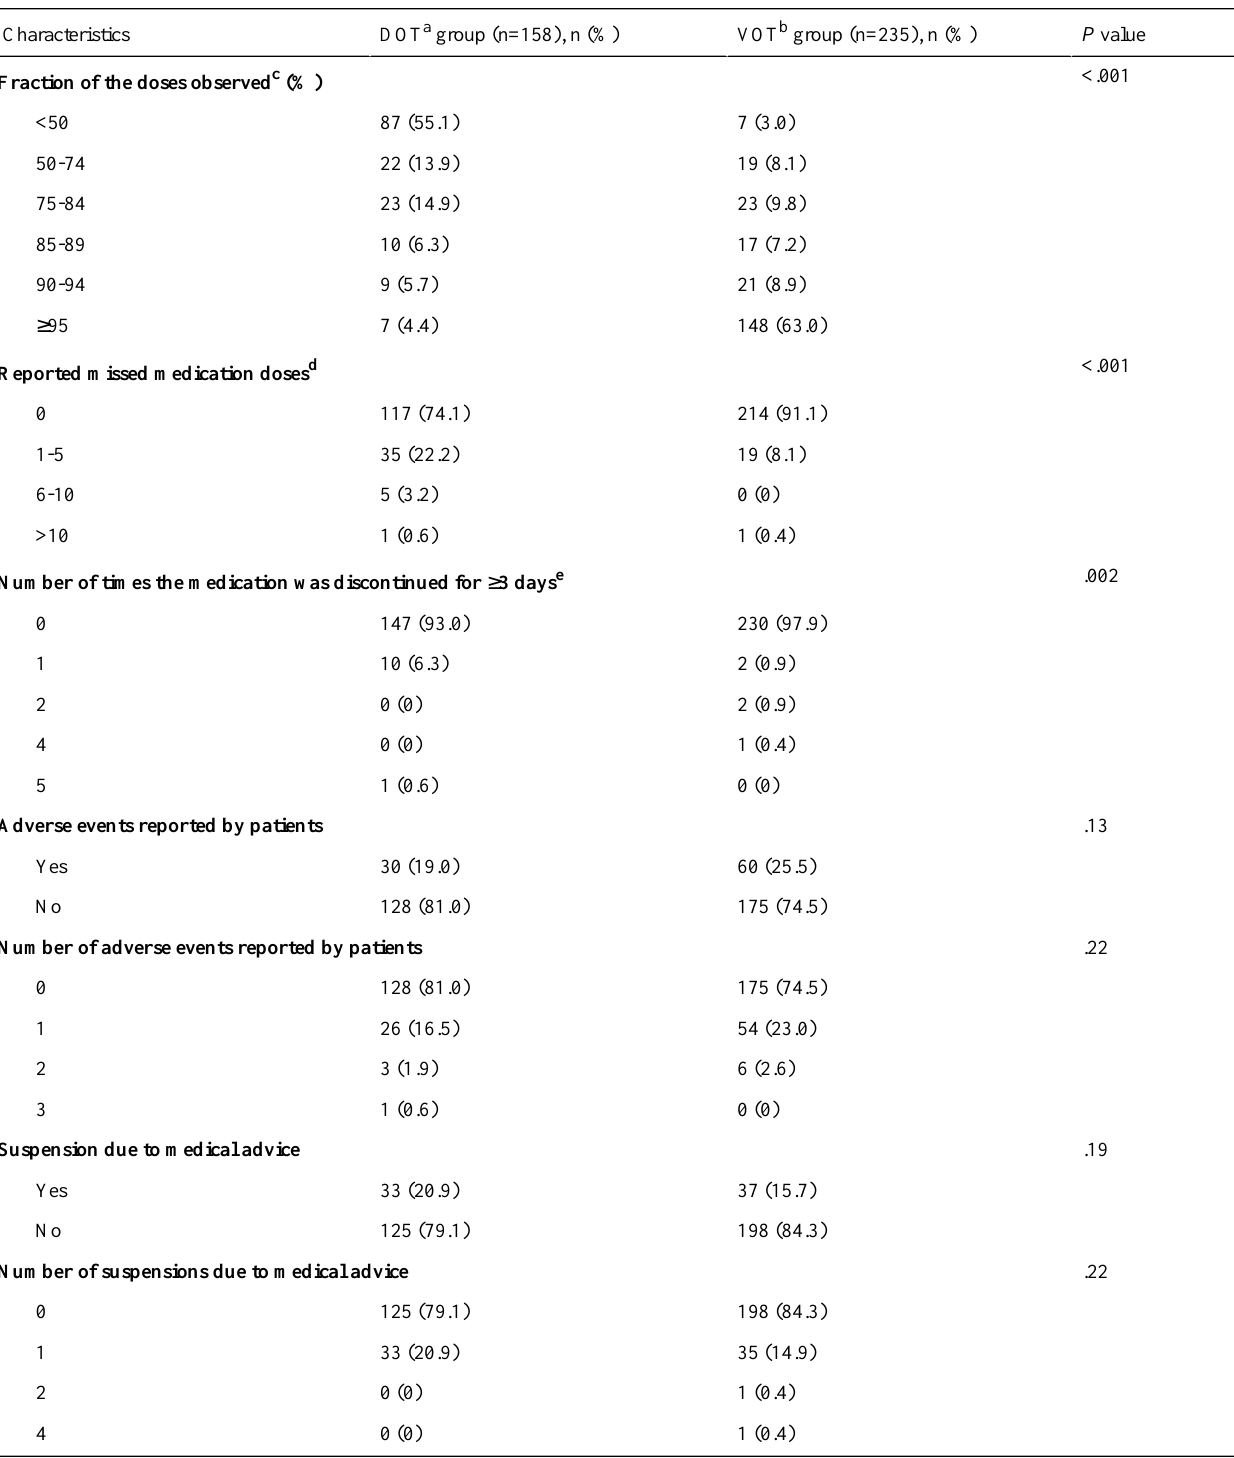
Table 3. Compliance with medication and adverse event management of the